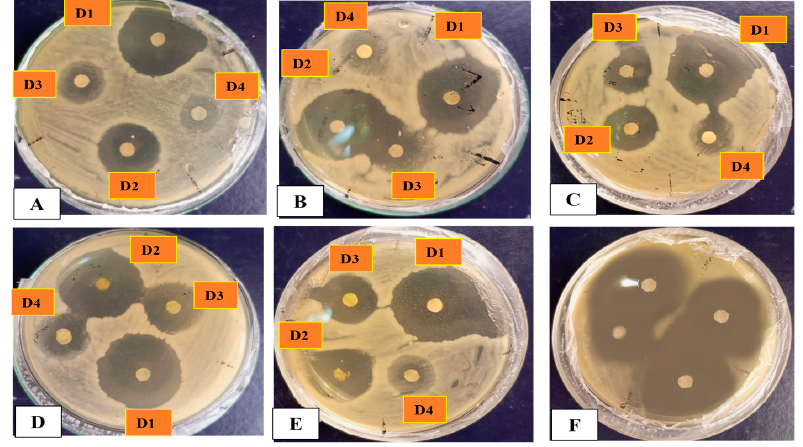
Figure 11. The zone of inhibition with different dilution (D1–D4) (1000-125 μ g/mL ) of various bacterial strains. ( A ) B. subtilus , ( B ) L. acidophilus , ( C ) S. aureus , ( D ) E. coli , ( E ) P. aeruginosa , ( F ) control (Oxytetracycline) against Ag 2 ONPs with different concentrations.